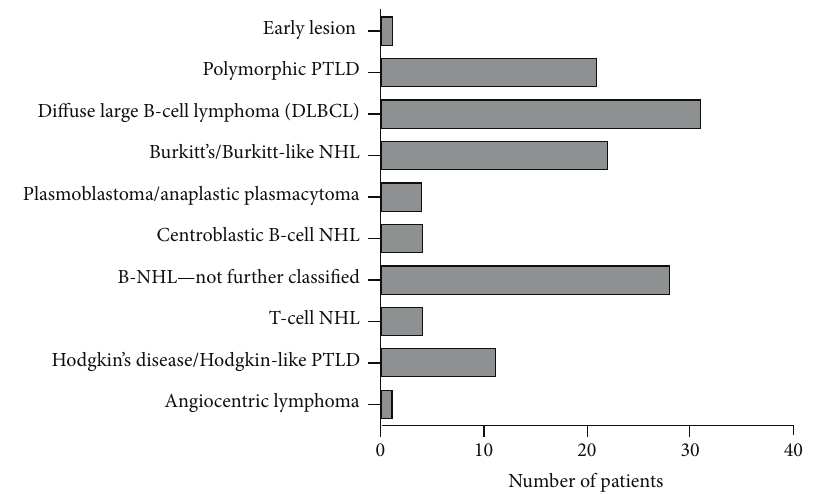
Figure 2: Distribution of histological subtypes of pediatric PTLD reported to the German Ped-PTLD